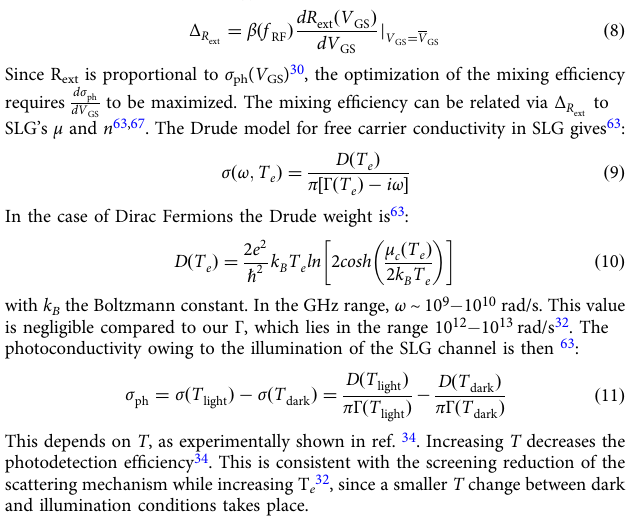
Fig. 8c plots the photoconductivity for n 0 between 10 11 cm − 2 (corresponding to high- quality SLG 50 ) and 5×10 11 cm − 2 (our case), while keeping μ fe = 2500cm 2 V − 1 s − 1 . In this case, the photoconductivity increases by a factor ~1.4 near the CNP, as well as at high doping ( V GS = 1 V ), with d σ ph / dV GS almost doubled, Fig. 8d. This means that the voltage operating point of the device can be decreased. Our prediction is based on the model presented in ref. 32 , which indicates the screening reduction of the Coulomb impurity scattering mechanism while increasing T 32 . For Coulomb scattering in samples with μ fe up to 1000cm 2 V − 1 s − 171 , this is disorder 33 , with two contributions: (i) random scalar potential and (ii) random gauge potential 33 . The fi rst is sensitive to T increase owing to screening reduction 33 , similar to